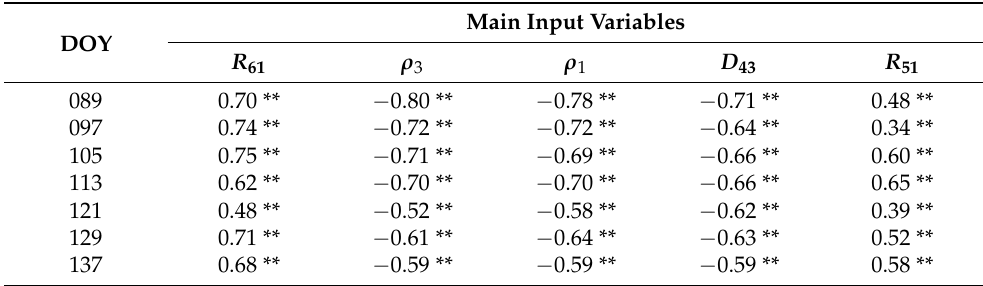
Table 7. Correlation coefficients between SOM and main input variables.